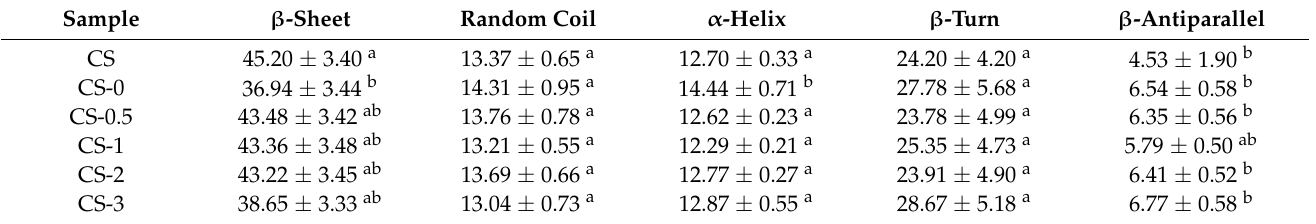
Table 7. Secondary structure percentage (%) analysis of Coregonus peled scale gelatin by analyzing the areas of 1600–1700 cm − 1 in FTIR spectra.